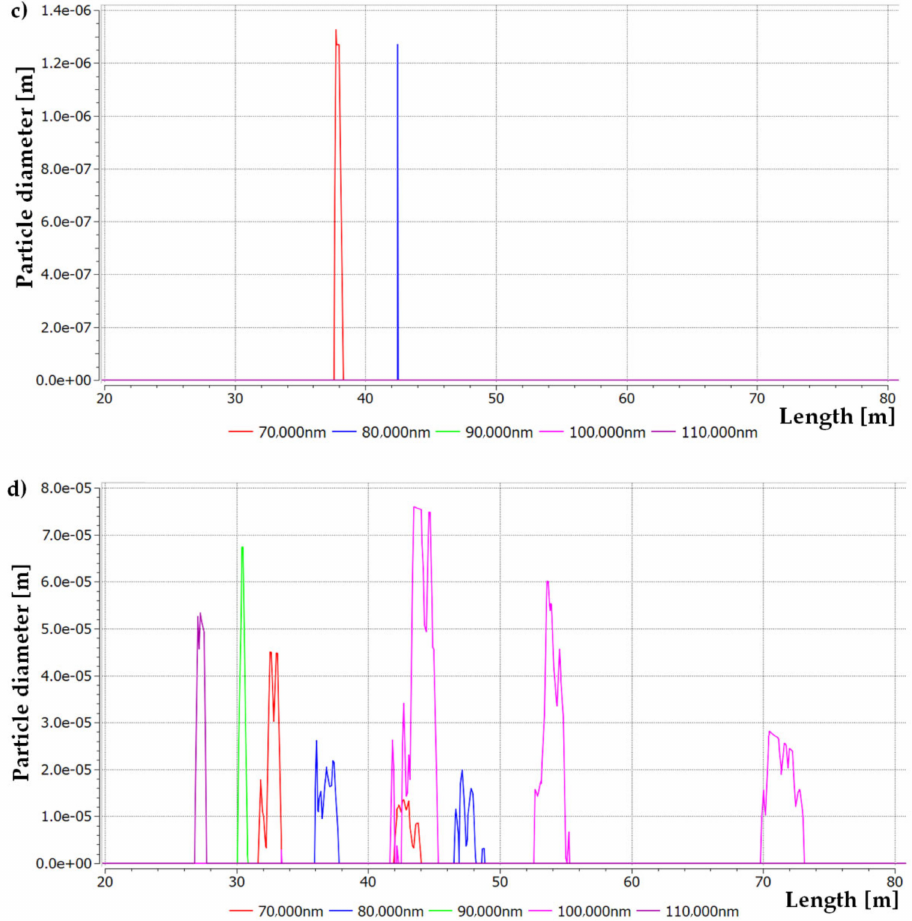
Figure 12. Forecasted distribution of aerosol droplet particle size changes depending on the length of the excavation at the following height: ( a ) 0.65 m above the floor, ( b ) 1.55 m above the floor, ( c ) 1.55 m above the floor at a distance of 1 m from the left aisle, and ( d ) 1.55 m above the floor at a distance of 1 m from the right